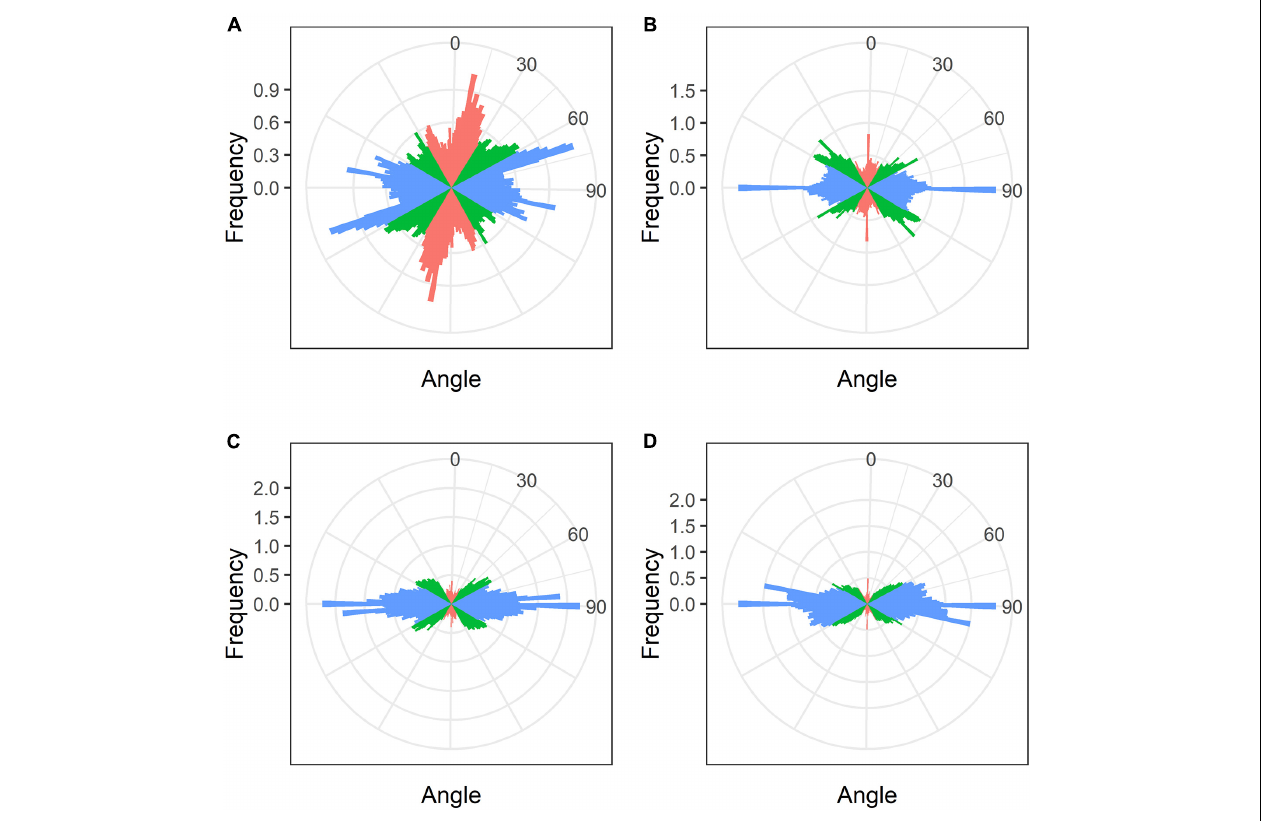
FIGURE 6 | Quantitative analysis of cortical microtubule orientation in uninfected cells of G. max (A) , G. soja (B) , P. vulgaris (C) , and L. japonicus (D) nodules. Color indicates the class of angles of the microtubules relative to the longitudinal axis of the cell: red, axial (0–30 ◦ , 150–180 ◦ ); green, oblique (30–60 ◦ , 120–150 ◦ ); blue, transverse (60–120 ◦